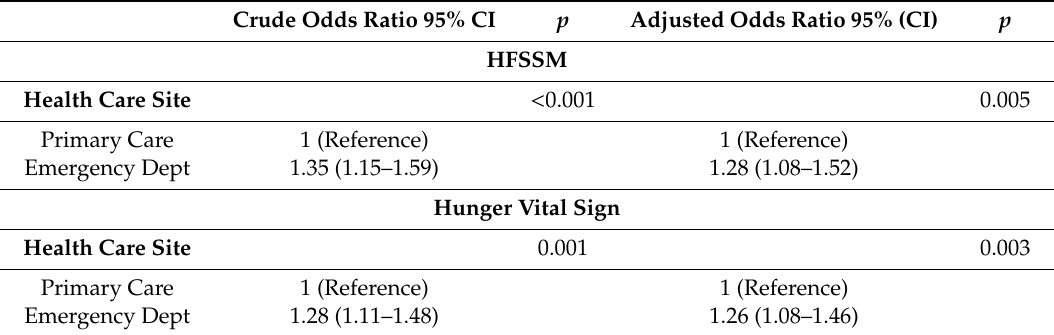
Table 2. Logistic regression of food insecurity based on HFSSM and Hunger Vital Sign related to health care site.